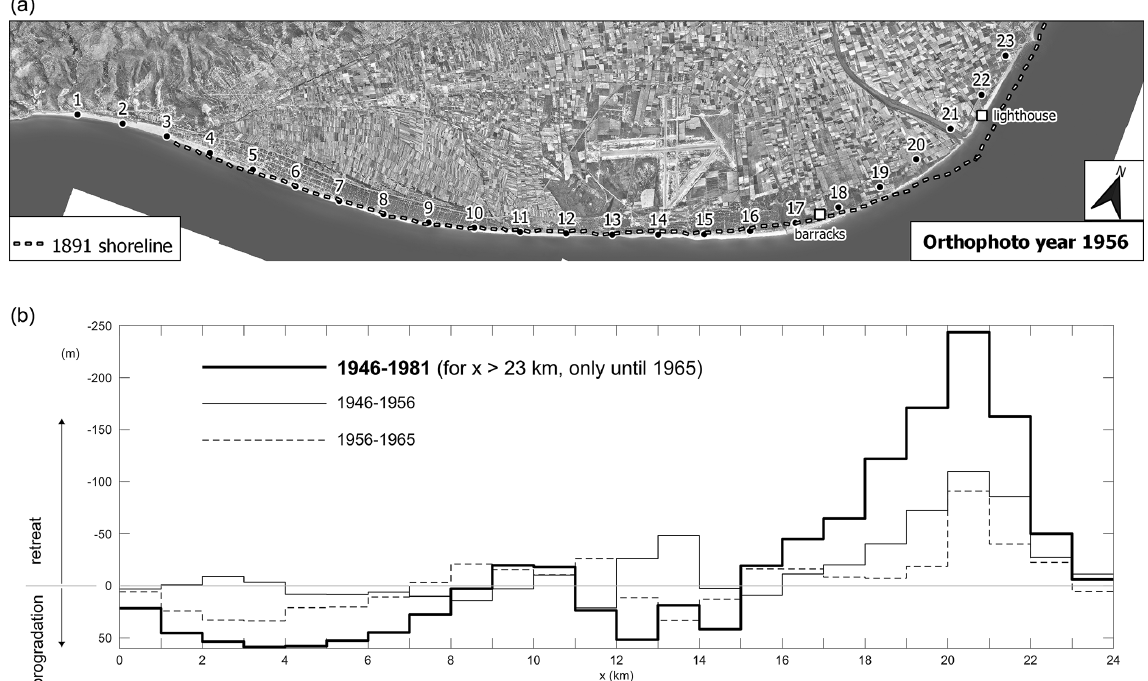
Figure 3. (a) The 24km long sedimentary unit (delta), produced by authors using freely available data from ICGC. (b) Total change in meters perpendicular to the coastline in ordinates (progradation + , or retreat − ) along the coastline above in the period 1946–1981 and in 2 decades within it. Apart from the lighthouse in Fig. 2, the history of the barracks at x ≈ 17 . 5km in 1844 is also known: from that date until 1934 the coastline prograded 179m (Paladella and Faura,